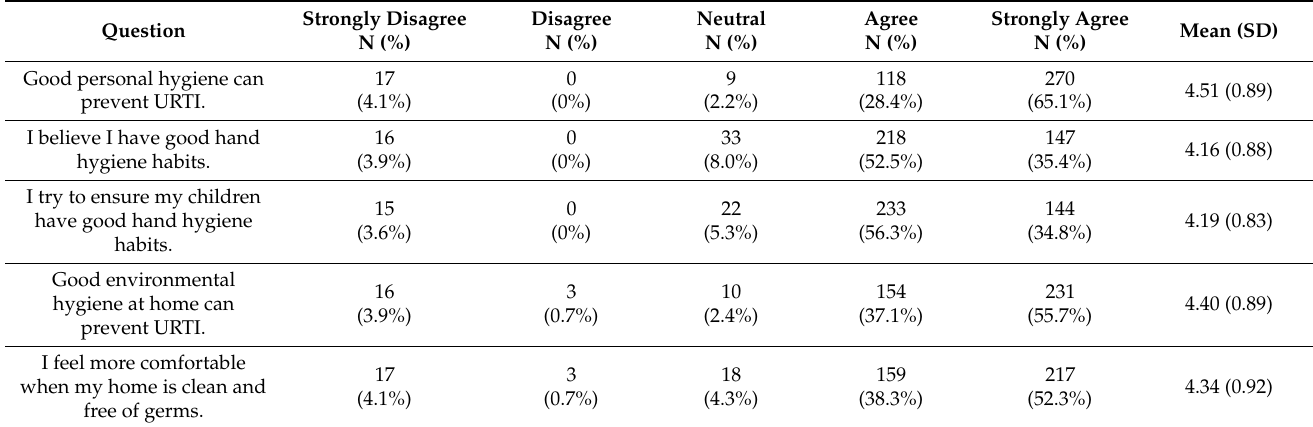
Table 4. Parental attitudes on hygiene measures for URTI